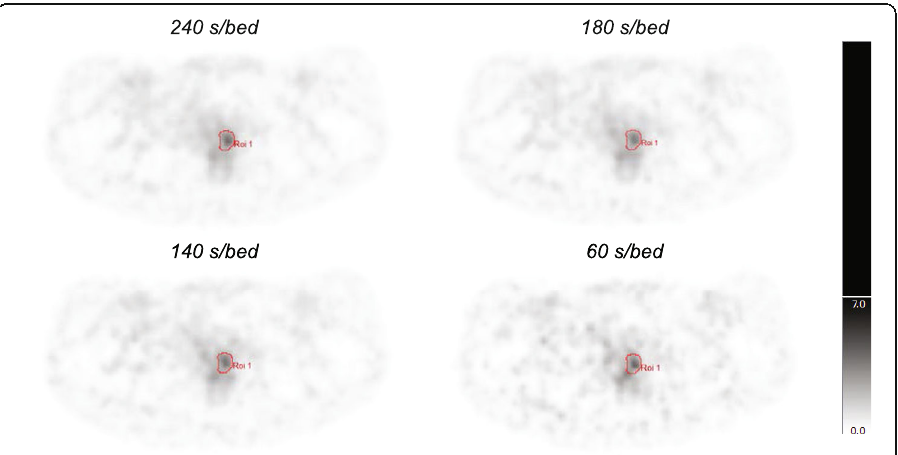
Fig. 5 Visualization of reconstructions of a lesion in the prostate, reconstructed with shorter acquisition